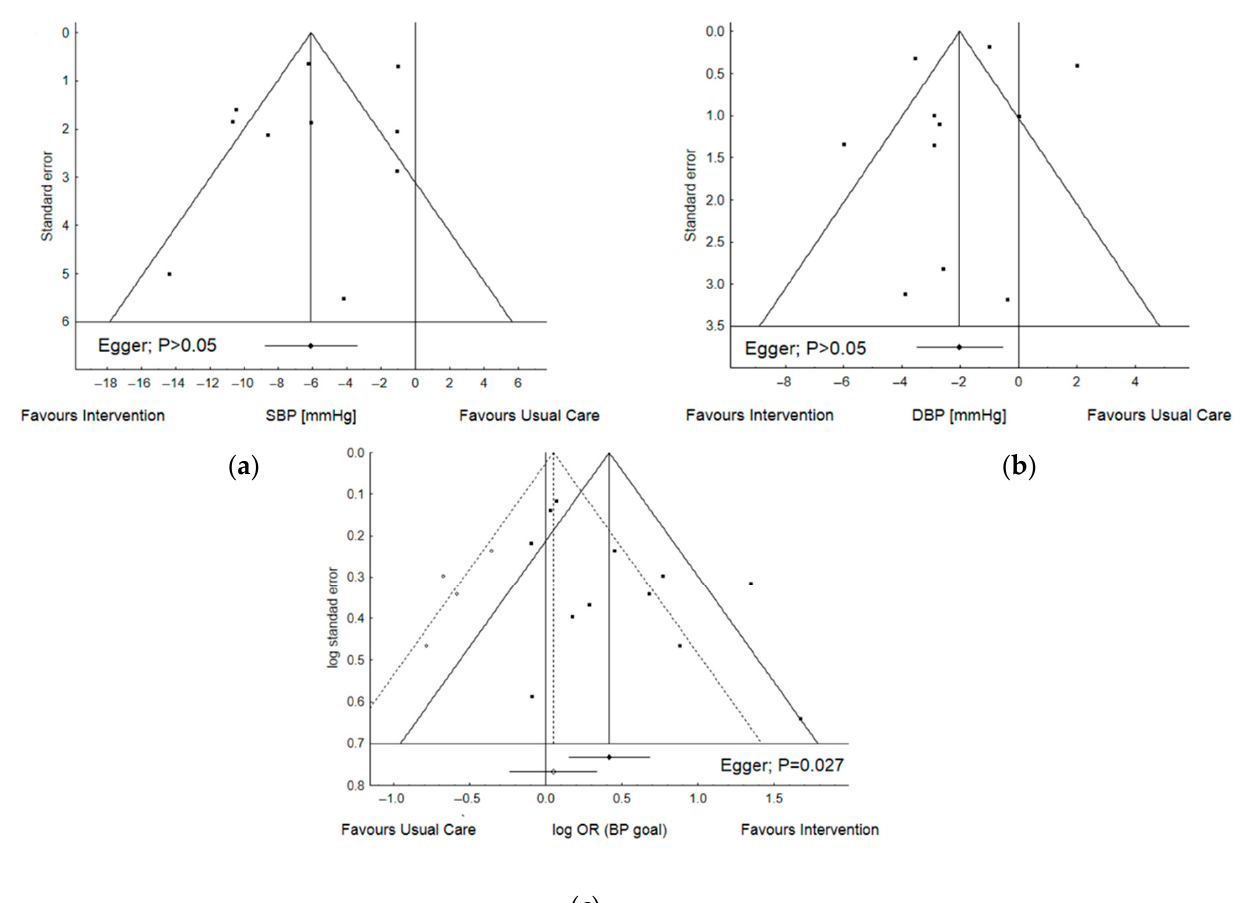
Figure 3. Funnel plot of the studies included in the meta-analysis of differential change from baseline in SBP ( a ) and DBP ( b ), as well as odds ratio for achieving BP goal ( c ). Graphs show the distribution of published study outcomes (filled squares) vs. unpublished outcomes (open circles) estimated by Trim and Fill analysis. The dashed line represents the mean and 95% CI with the added, potentially unpublished, studies, and the solid line represents published studies included in meta-analysis. Vertical dashed line represents the global estimate of efficacy. Overall effect size D = − 5.86 [ − 8.31, − 3.41] —0 potentially missing studies were added ( a ); D = − 3.30 [ − 3.88, − 2.72]—0 potentially missing studies were added ( b ); OR = 1.52 [1.16, 1.98] vs. 1.05 [0.79, 1.40]—6 potentially missing studies were added ( c